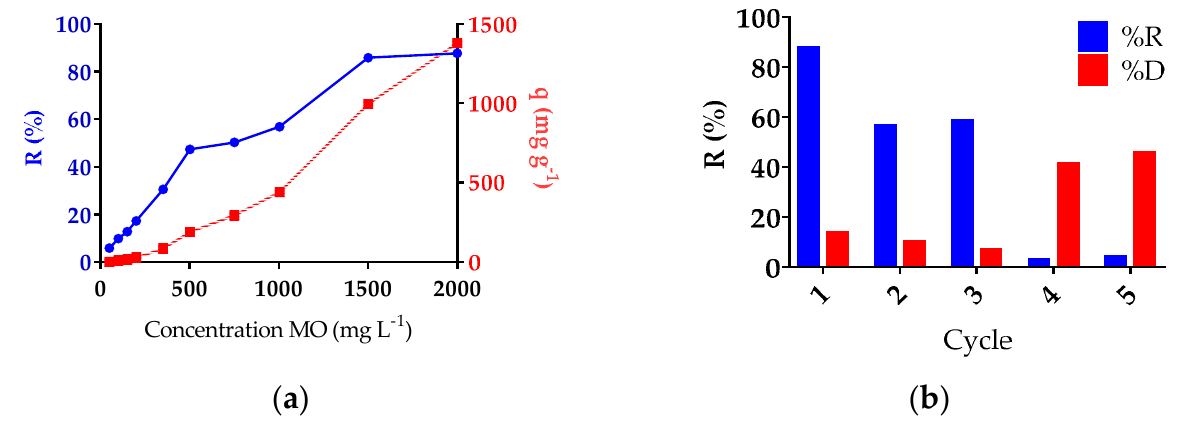
Figure 9. Removal of MO dye at pH 3, 7.64, and 10. y -axis: right—MO retention (%R); left—adsorption capacity (q).